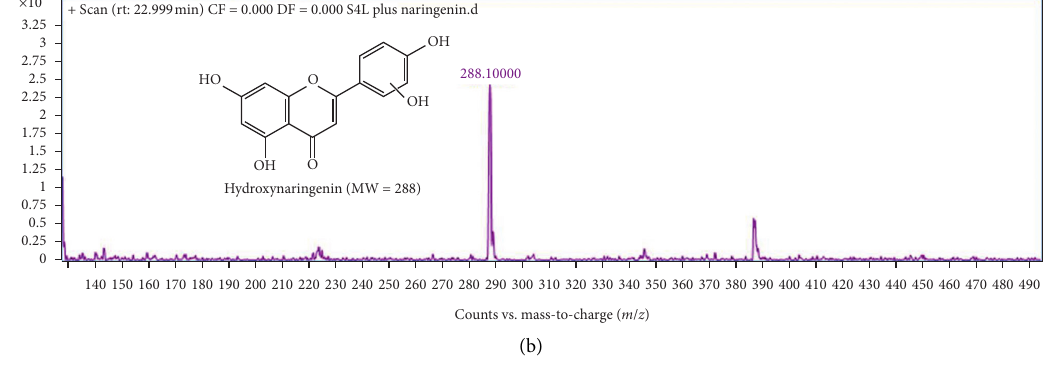
Figure 6: Mass spectra of naringenin and its products by Streptomyces species